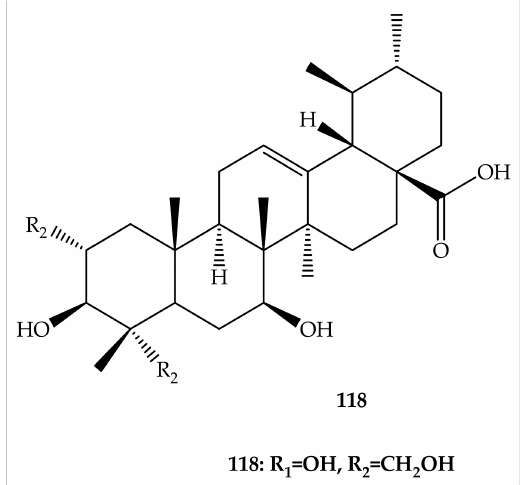
Figure 11. Some derivatives prepared by modification of UA with interesting potential as therapeutic